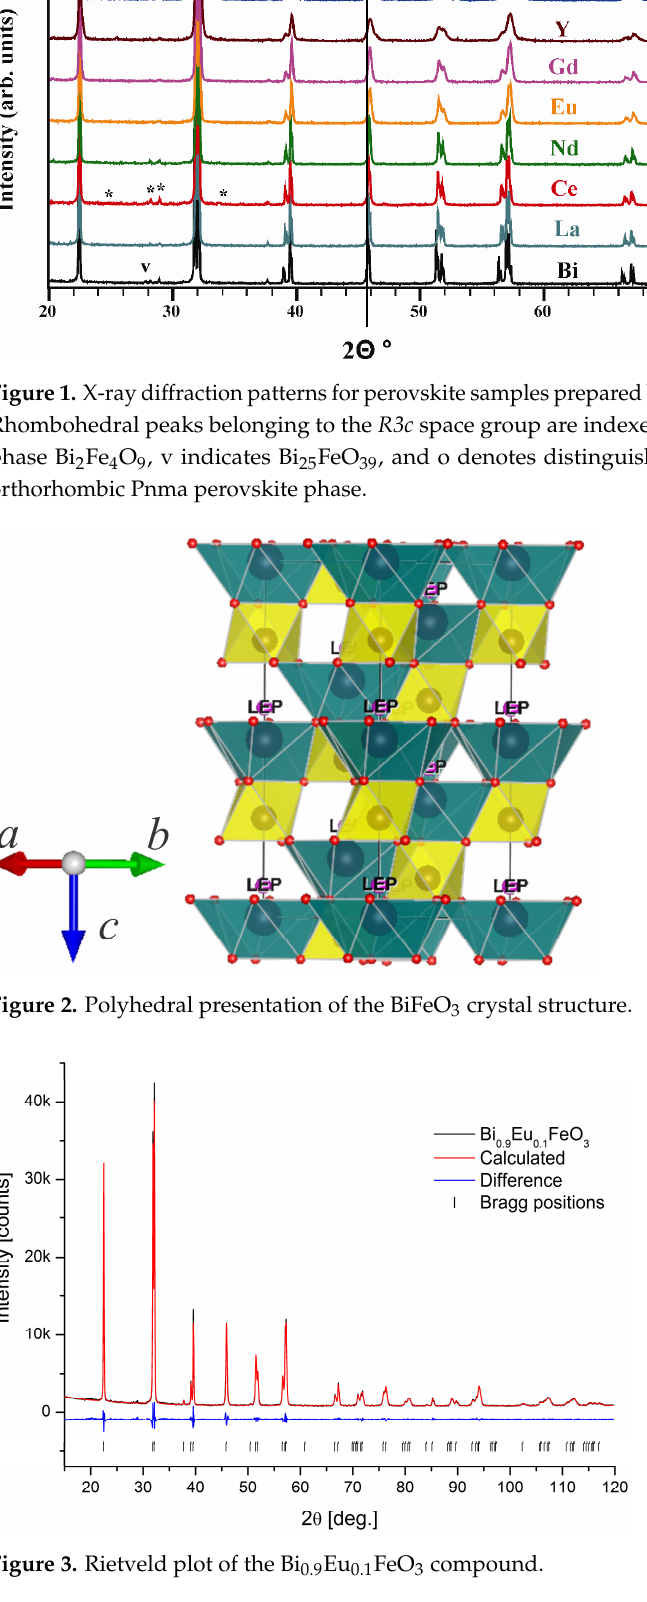
Figure 3. Rietveld plot of the Bi 0.9 Eu 0.1 FeO 3 compound. Table 2. Refined structural parameters for BiFeO 3 and substituted Bi 0.9 RE 0.1 FeO 3. The special atomic coordinates are as follows: Bi,RE (0, 0, 0) and Fe (0, 0, z). For the Bi 1 RE 1-x FeO 3 phases that crystallize in SG Pnma, only occupation numbers of A-cation position and weight quantity are listed. The thermal displacement parameters are calculated as Beq = 8 × π ² × Uiso. Sample Bi La 0.1